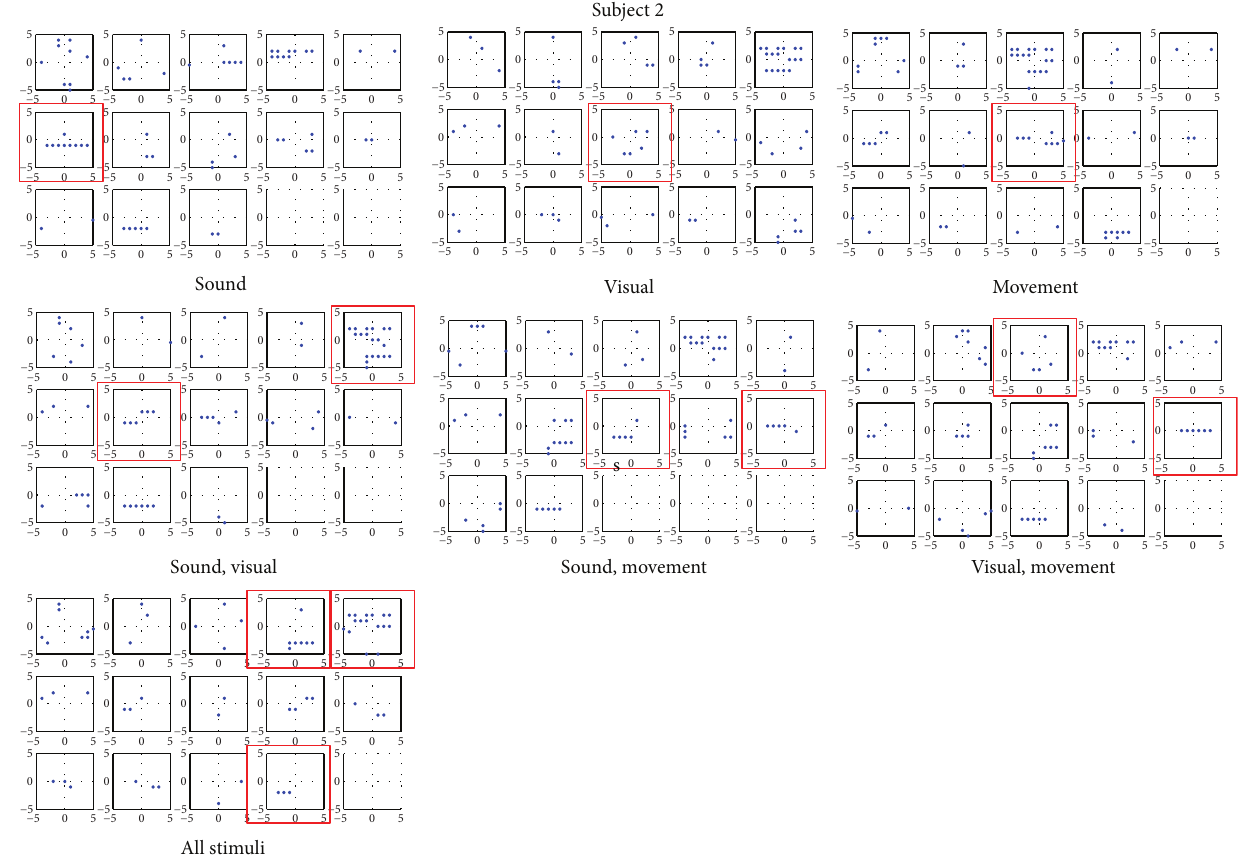
Figure 4: Results of grouping for Subject